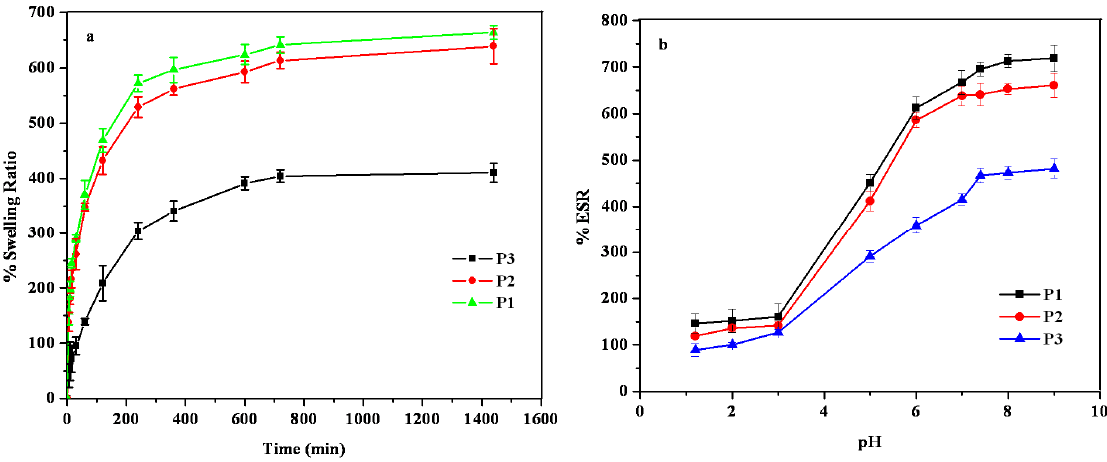
Figure 6. ( a ) Swelling studies of PPK hydrogels in DDW at 37 °C and ( b ) %ESR of PPK hydrogels at various pH conditions.